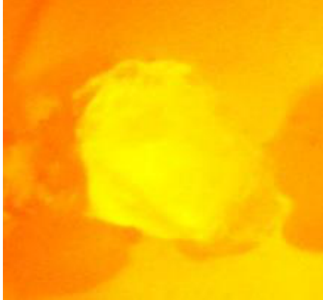
Figure 10. Reconstructing 3D models of silica crystals using the SFS algorithm.